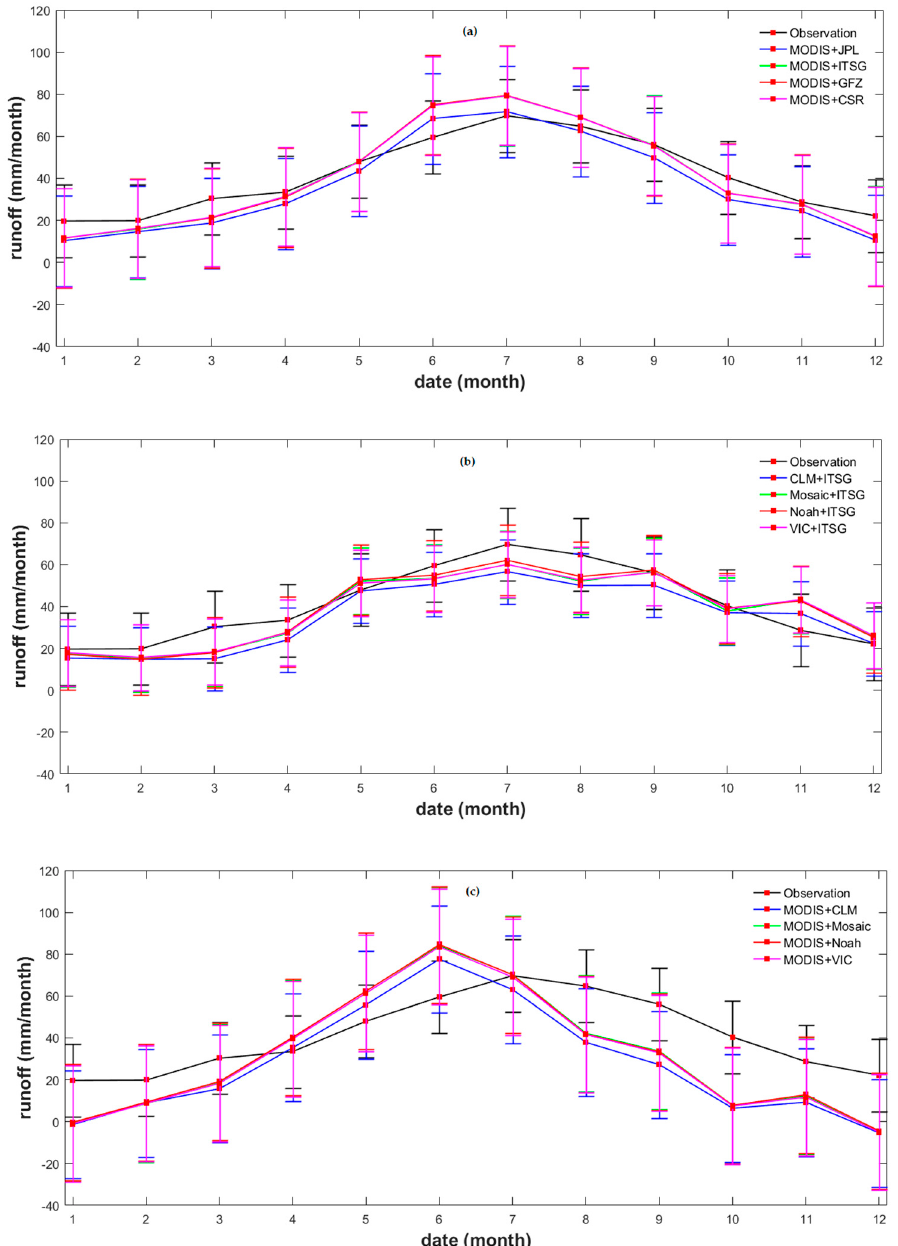
Figure 9. Mean monthly runoff in the Yangtze river basin derived from ( a ) MODIS evapotranspiration and several GRACE terrestrial water storage; ( b ) several GLDAS evapotranspiration and ITSG GRACE terrestrial water storage; and ( c ) MODIS evapotranspiration and several GLDAS terrestrial water storage data.